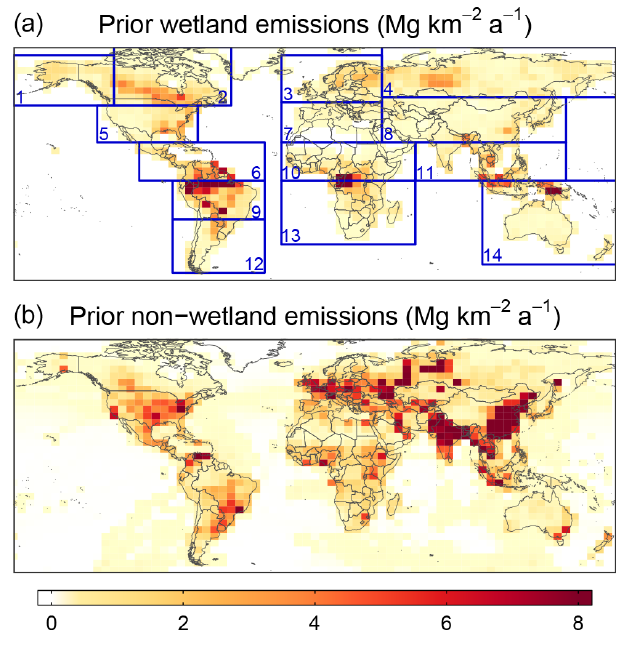
Figure 1. Spatial distribution of mean 2010–2018 methane emis- sions used as prior estimates in the inversion of GOSAT data. The top panel shows wetland emissions, and the bottom panel shows non-wetland emissions. Blue boxes indicate the 14 sub- continental regions for which wetland emissions are optimized for individual months (Sect. 2.2): (1) Alaska + western Canada, (2) eastern Canada, (3) northern Europe, (4) Siberia, (5) temper- ate North America, (6) Latin America, (7) the Mediterranean, (8) East Asia, (9) the Amazon, (10) sub-Saharan Africa, (11) tropical South Asia, (12) Argentina, (13) southern Africa, and (14) Indone- sia +